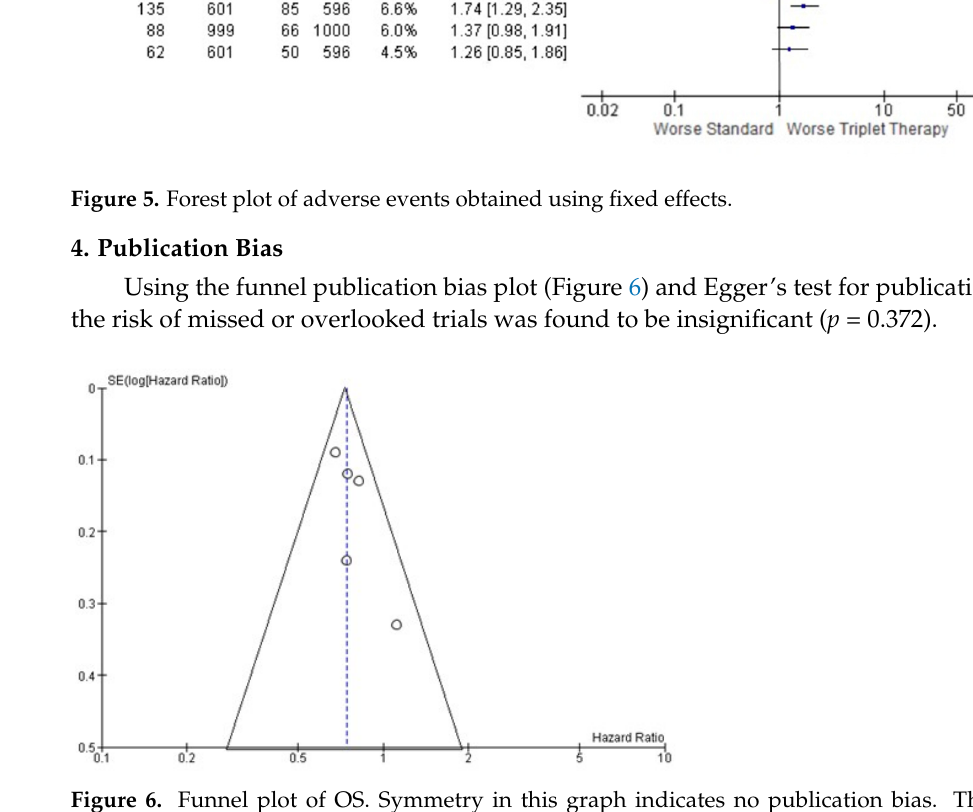
Figure 6. Funnel plot of OS. Symmetry in this graph indicates no publication bias. The circle represents the HR of each single study.